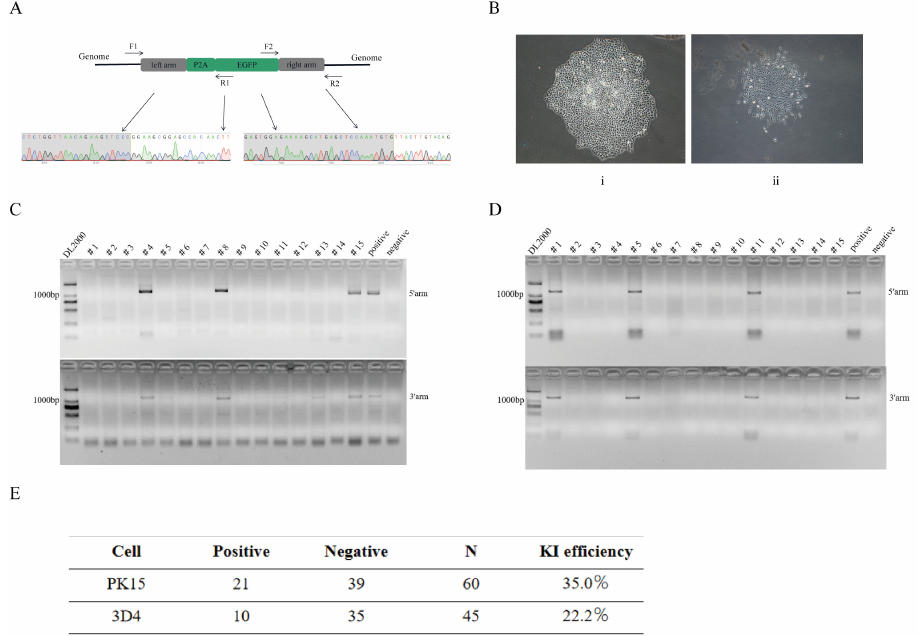
Figure 3. Detection of knock-in efficiency in pk-15 and 3D4/21 cells. ( A ) Nucleotide sequence analysis of junctions between endogenous and exogenous DNA corresponding to HDR events. F1/R1 and